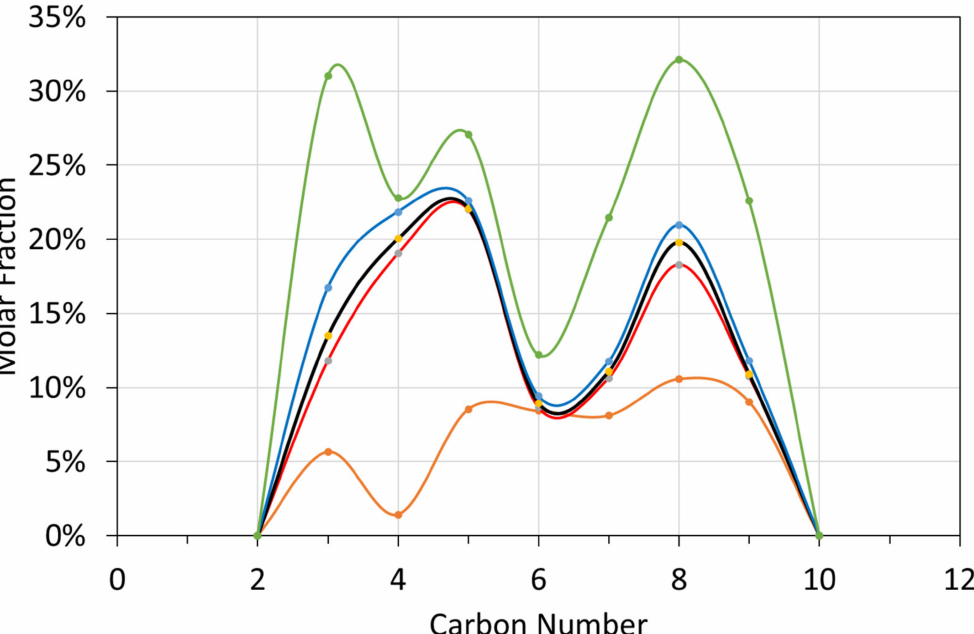
Figure A3. Molar liquid composition probability distribution vs. carbon number: T ≤ 298 K; brown = minimum; red = first quartile; black = median; blue = third quartile; green = maximum. brown line = minimum value (0%); red line = first quartile value (25%); black line = median value (50%); blue line = third quartile value (75%); green line = maximum value (100%).